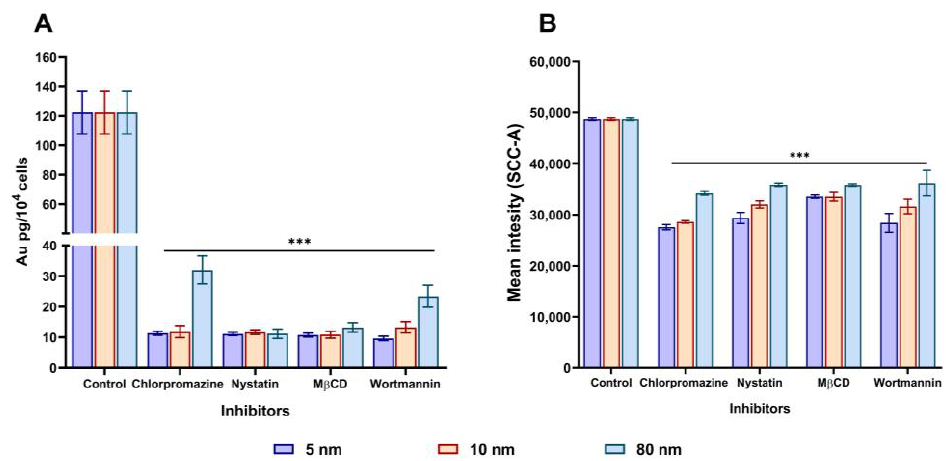
Figure 4. Effects of pharmacological inhibitors on the internalisation of different sizes of AuNPs (30 µ g/mL) in A549 cells. Cells were separately pre-incubated with chlorpromazine, nystatin, M β CD, and wortmannin for 1 h, followed by incubation with AuNPs for 3 h and analysed by ( A ) ICP-MS and ( B ) flow cytometry. Plotted graphs represent the means ± SD of three independent experiments. Bars with an asterisk (*) show a statistical difference (*** p < 0.001) when compared with the control.